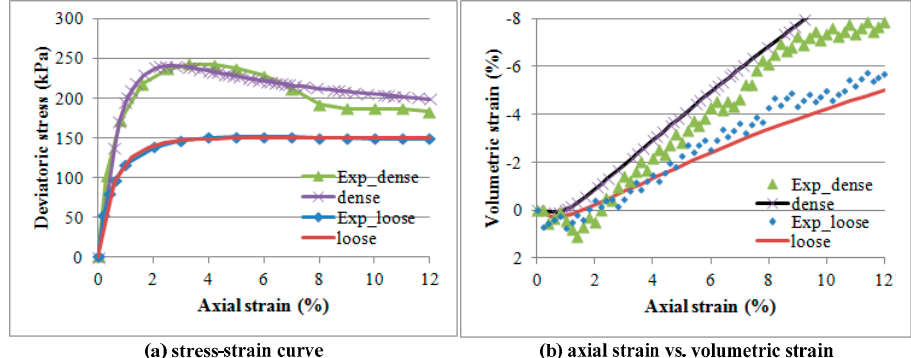
Figure 12. Model predictions of in global behavior for dense or loose homogeneous specimen.